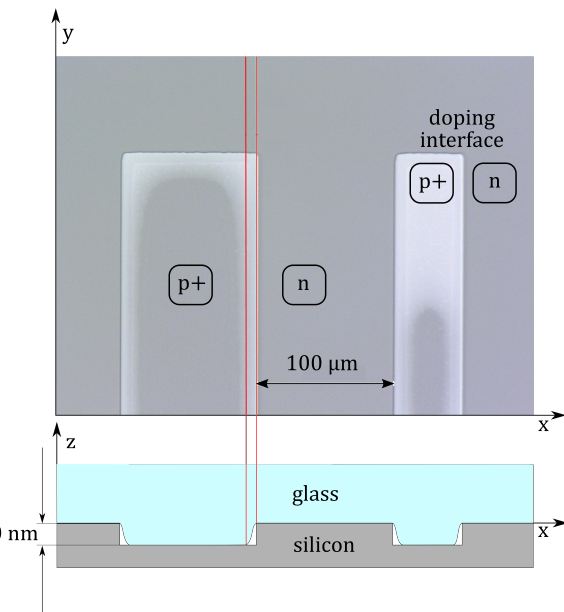
Figure 6. Top-view micrograph of a test structure with differently doped silicon regions, anodically bonded to glass. Lighter gray areas reveal the formation of non-bonded channels along the interface between differently doped silicon areas. A schematic cross-section illustrates this problem.